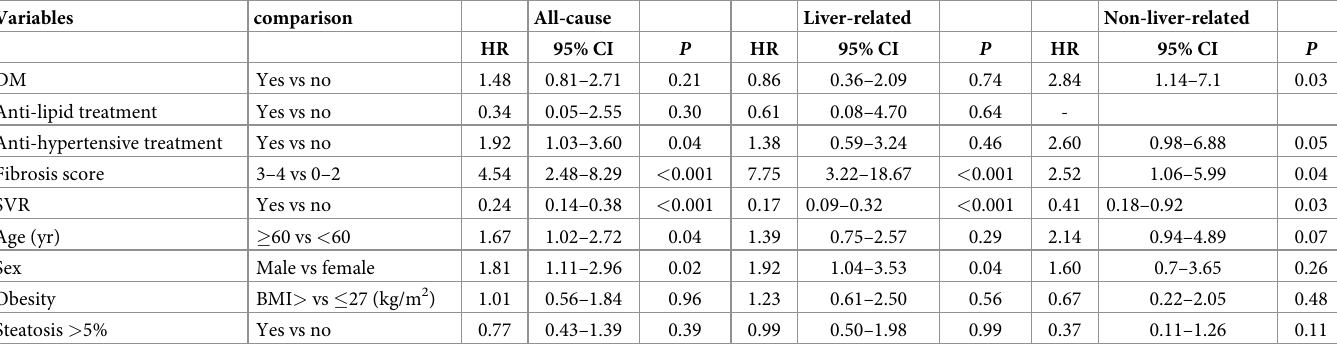
Table 2. Features Associated With Mortality in All Patients (N = 1452) According to Cox Proportional Hazards Model:Results of Multivariate Analyses. Variables